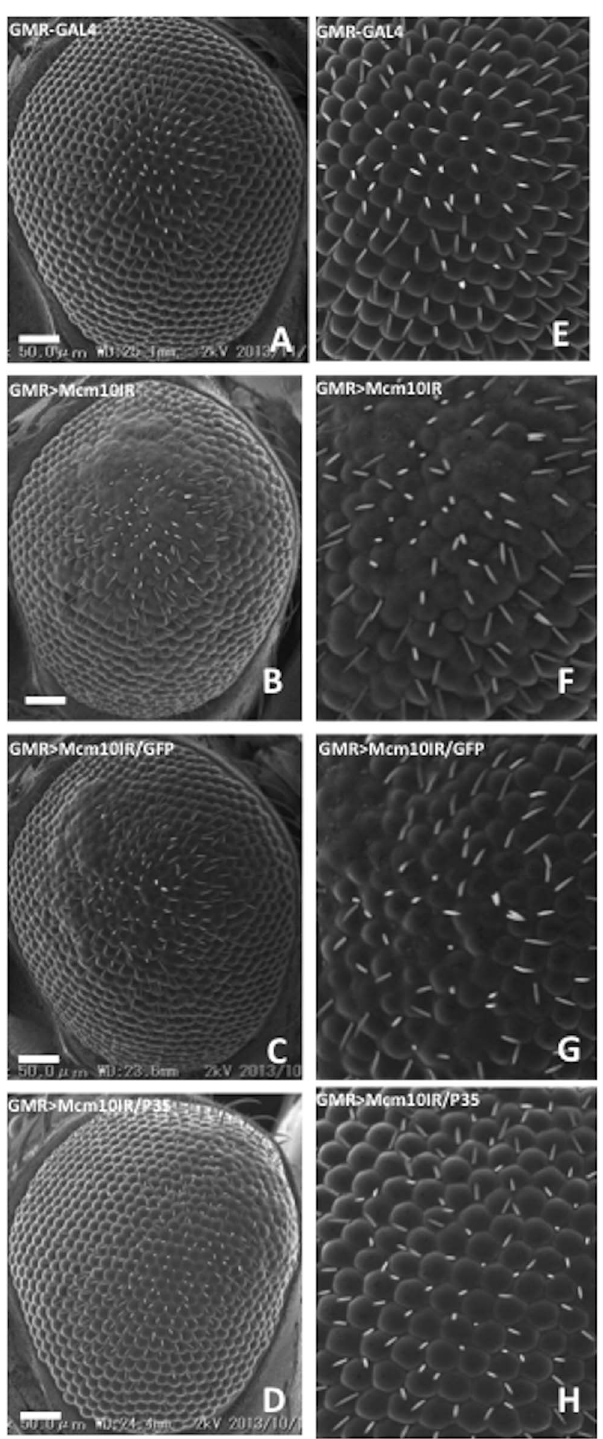
Figure 8. Expression of apoptosis inhibitor P35 suppressed the rough eye induced by knockdown of dMcm10 . Scanning electron micrographs of adult compound eyes. Posterior is to the right and dorsal is to the top. The flies were reared at 28 u C. The bar indicates 50 m m. (A) GMR -GAL4/ yw ; + ; + ; (B) GMR -GAL4/ yw ; + ; UAS- Mcm10IR 633- 700 / + ; (C) GMR -GAL4/ yw ; + ; UAS- Mcm10IR 633-700 /UAS- GFP ; (D) GMR - GAL4/ yw ; + ; UAS- Mcm10IR 633-700 /UAS- P35 . E, F, G, and H show enlarged images of A, B, C, and D, respectively. White bars indicate 50 m m. The flies were reared at 28 u C.